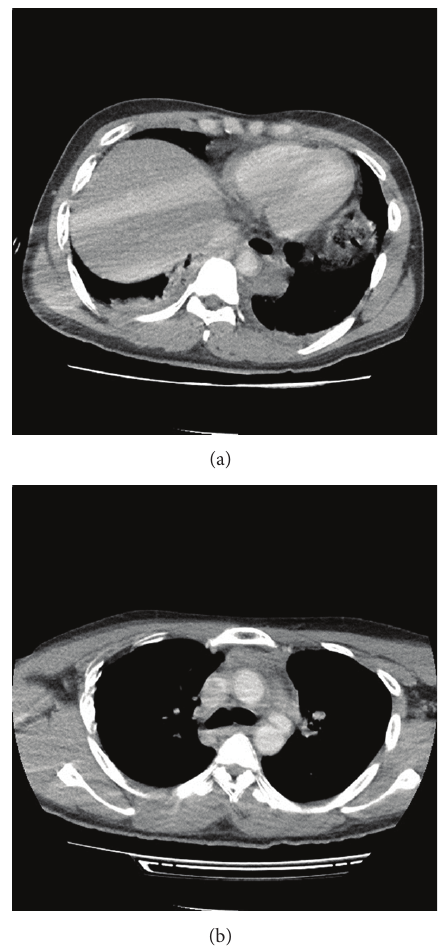
Figure 2: Computed tomogram showing (a) 2 × 1cm contrast-filled outpouching at the anterolateral aspect of the distal aortic arch with (b) associated mediastinal fat stranding and crescentic soft tissue density along the descending thoracic